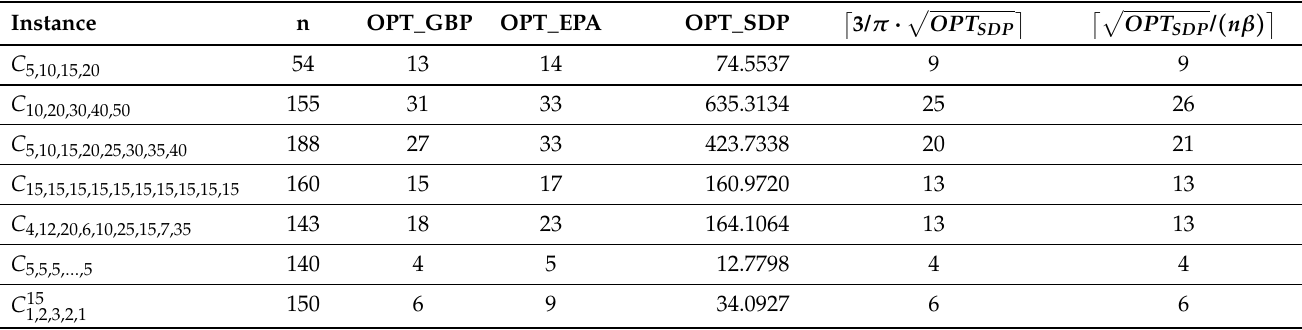
Table 4. Results on caterpillars with a hair length of